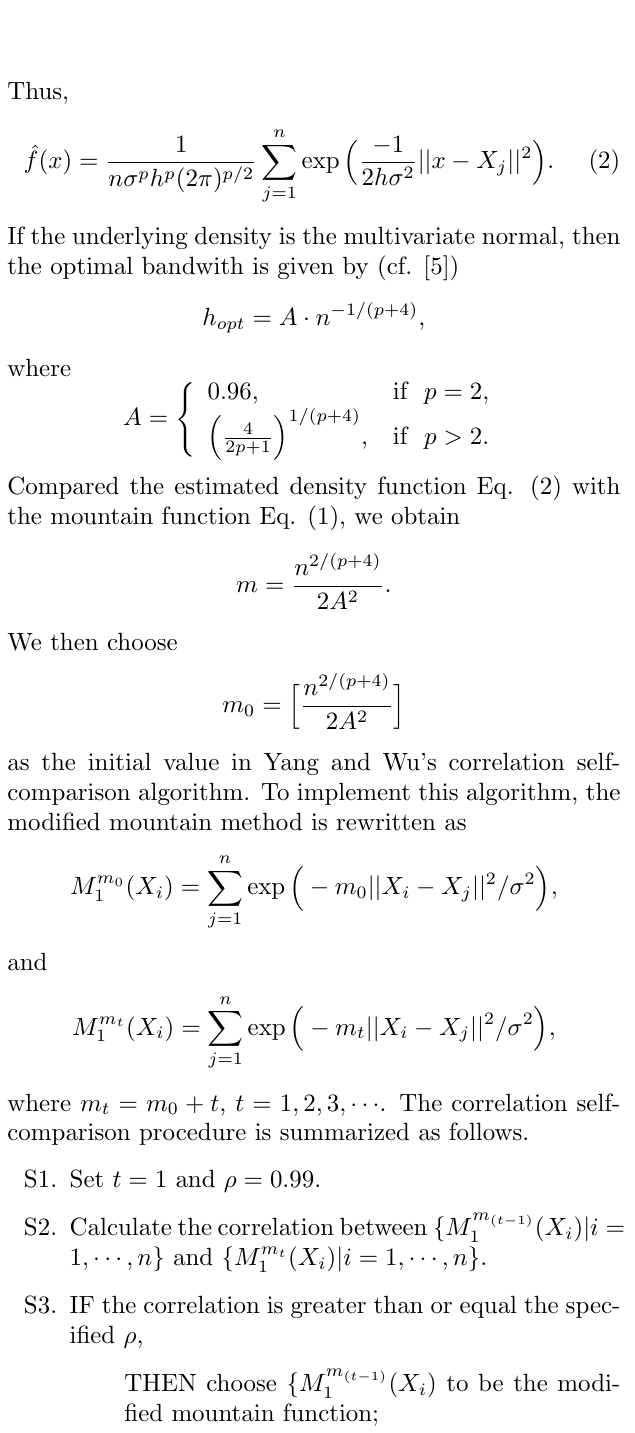
ble 1 (cf. Table 1 in Huang et al. [2]) to demonstrate that the performance of Yang and Wu’s [6] modified mountain clustering algorithm is affected by diverse (or noise) vari- ables. Fig. 1.1 shows the subspace of ( x 0 , x 1) with three normally distributed clusters. Fig. 2.1 presents the sub- space of ( x 0 , x 4) with uniformly distributed noise points. Figs. 1.1 and 1.2 demonstrate Yang and Wu’s [6] mod- ified mountain function with a good and poor density shape when the data set with normally distributed and the noise variable exists, respectively. These results illus- trate that the noise variable influences the performance of clustering